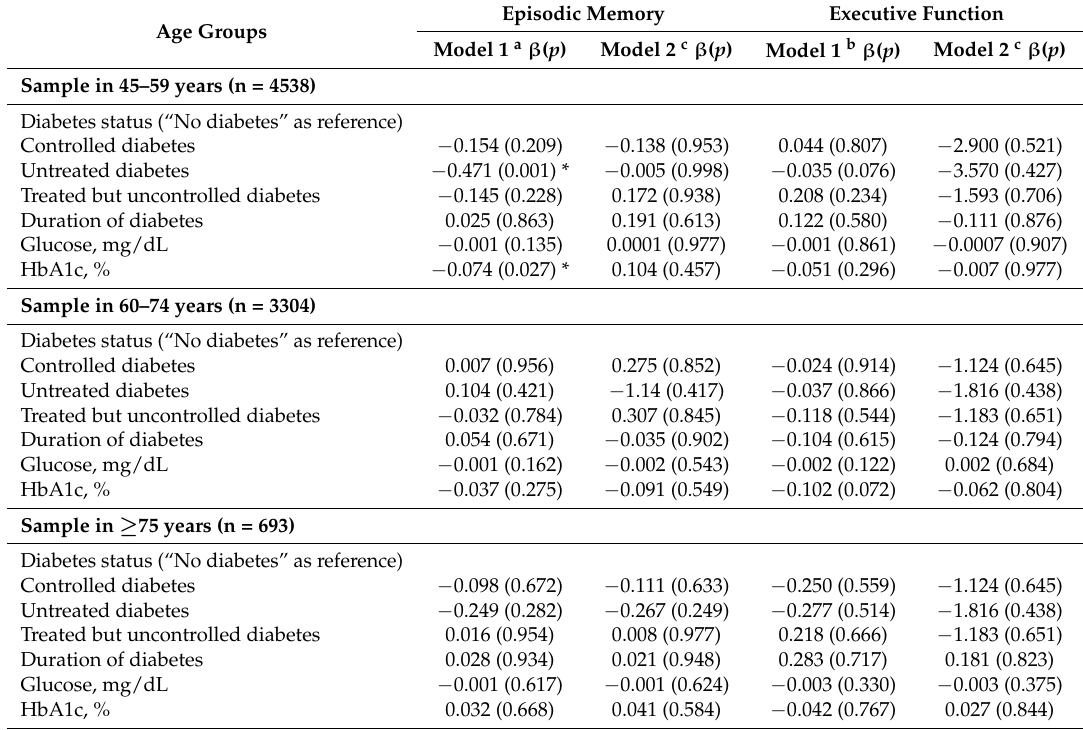
Table 4. Association between diabetes status and cognition in different age